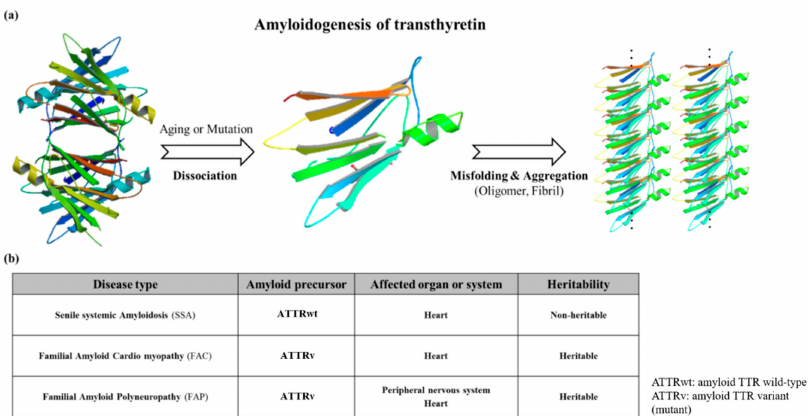
Figure 3. ( a ) Schematic diagram showing the amyloidogenesis of transthyretin. Transthyretin amyloidosis requires tetramer dissociation to monomer. (Transthyretin tetramer—PDB ID code; 4PVL83, Transthyretin monomer—PDB ID code; 3I9A84, Fibrils structure is made by ATTRv monomer without calculation); ( b ) Types of transthyretin